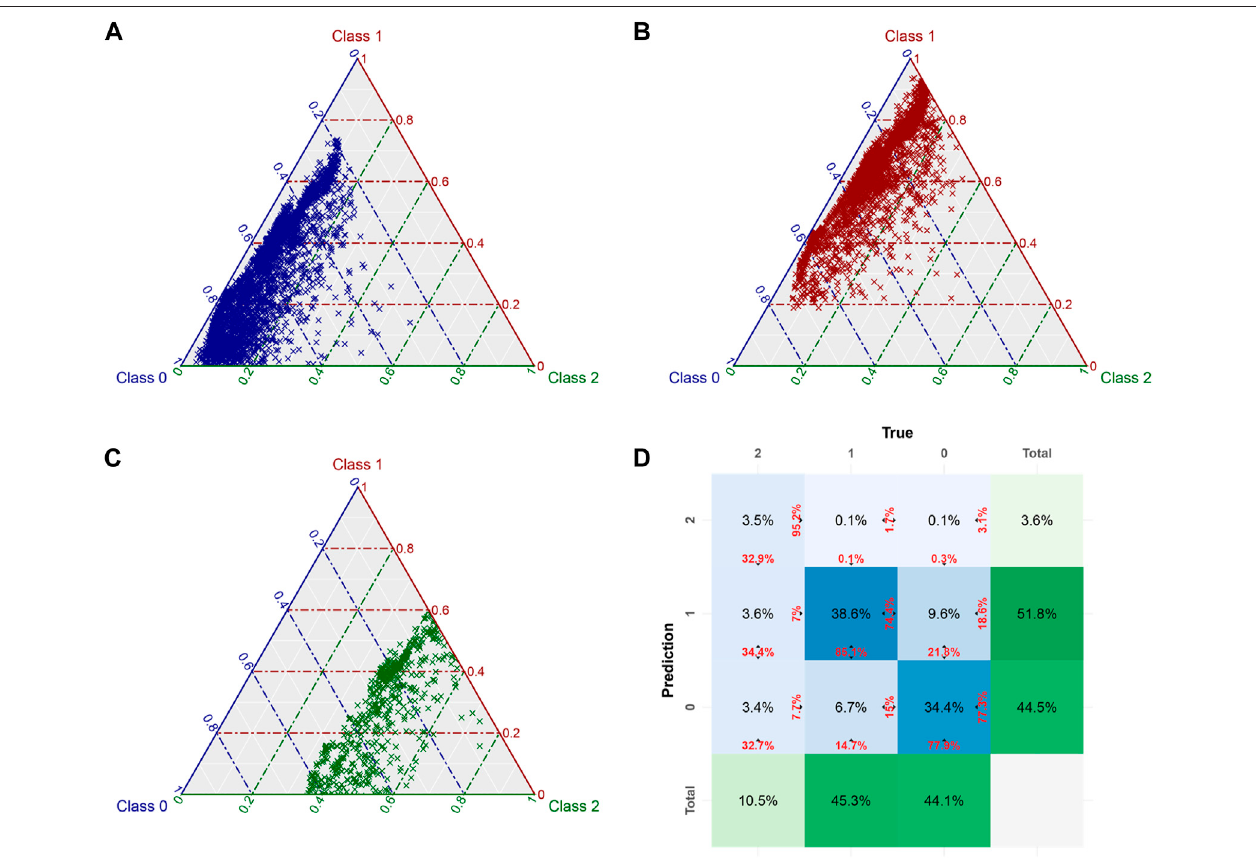
FIGURE7| Ternaryprobabilitydiagramsshowingtransferlearningresultsfor (A) class0, (B) class1,and (C) class2usingthetestdata.Class0,class1,andclass 2 are shown in blue, red, and green, respectively; the color of the dot itself represents the real class, and the distance projected from each dot to each class axis represents the probability of that class in the model prediction. (D) Confusion matrix indicating the distribution of the predicted and true values. The normalized count (overall percentage) is shown in the center of each tile. The column percentage is shown at the bottom of each tile, and the row percentage is shown on the right. Sum tiles to the right and bottom of the plot show the overall distribution of predictions and targets. Note that the color intensity is based on the counts.